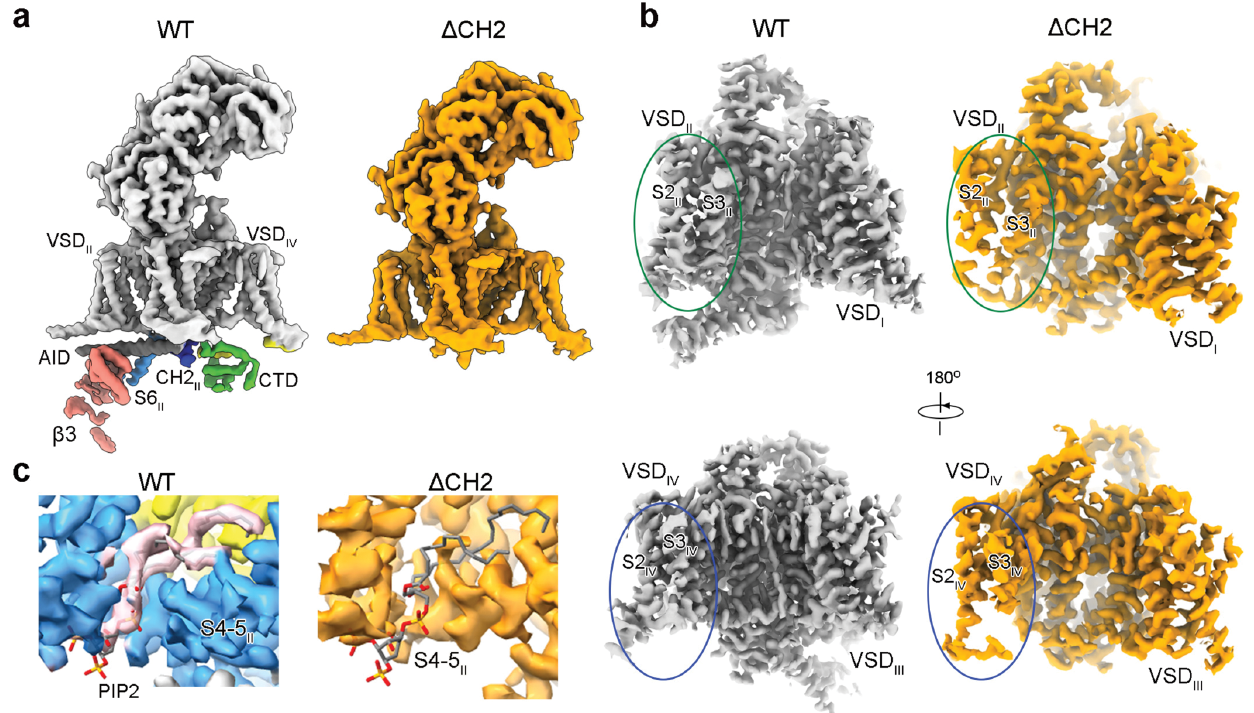
fi lteredto6Å. b VSD II (top)andVSD IV (bottom)displaydiscontinuousdensitiesfor the S2 and S3 segments in the absence of the CH2 II helix. c PIP2 is not resolved in Δ CH2map.ThedensityforPIP2,coloredpinkintheWTmap,ismissinginthemap of Δ